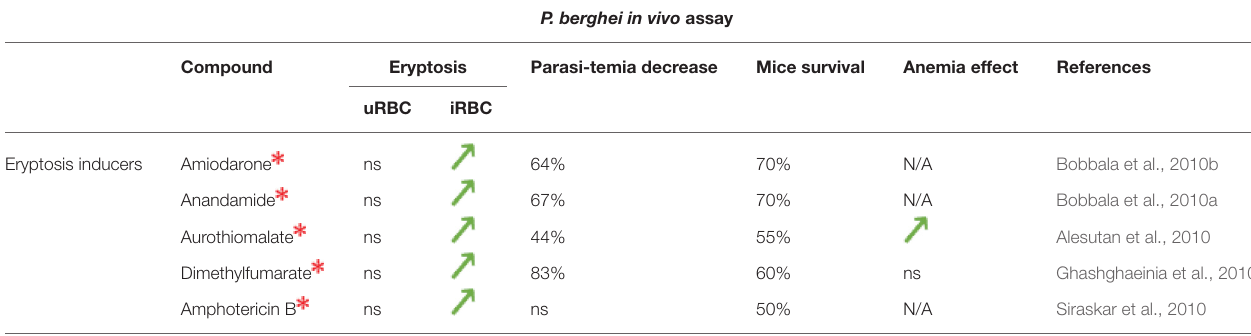
TABLE 4 | Effect of eryptosis inducers on P. berghei in vivo